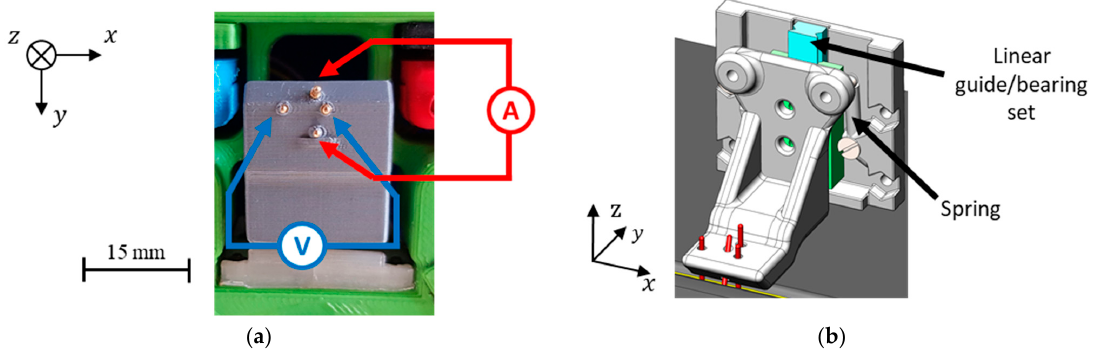
Figure 10. Four-point probe based on the numerical simulation-based preferred arrangement of the pins (orthogonal pattern). ( a ) Produced probe; ( b ) CAD model.